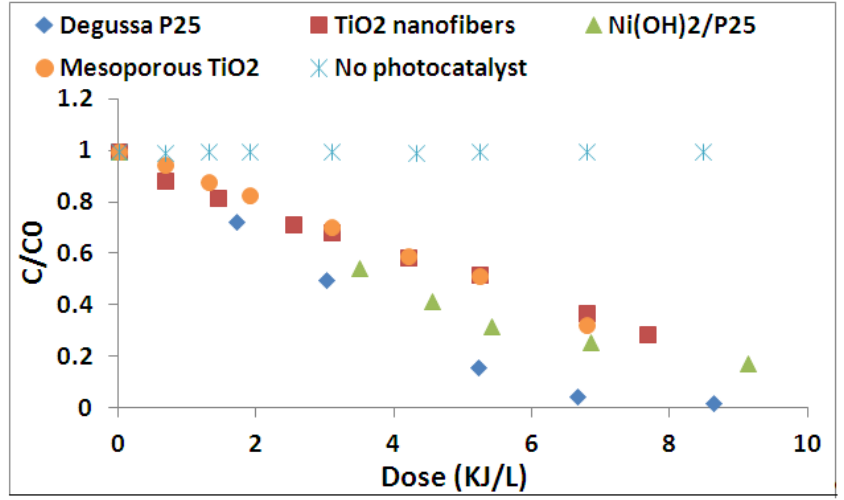
Figure 5. Degradation of SMX (33 ppm) irradiated in 365 nm LED reactor using Degussa P25, TiO nanofibers and Ni(OH) /TiO Absorbance at 266 nm was monitored. Irradiation 2 2 2. times are converted to required energy per volume in (kJ/L) for the corresponding removal of SMX shown on the Y axis.